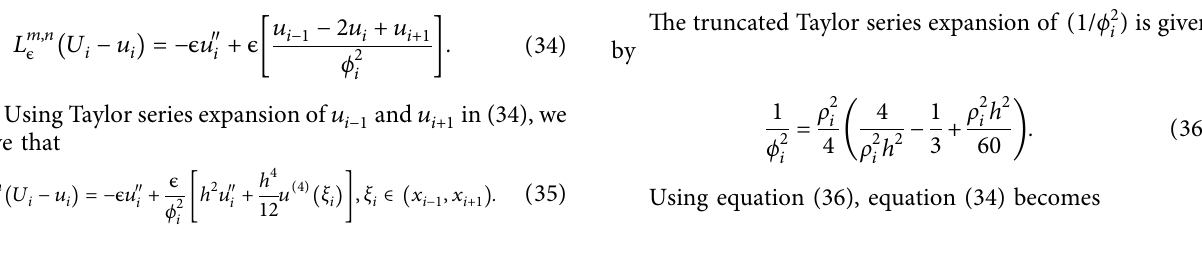
Figure 2: The physical behavior of the solutions for Example 2 for m � 20, n � 20, and ε � 10 − 10